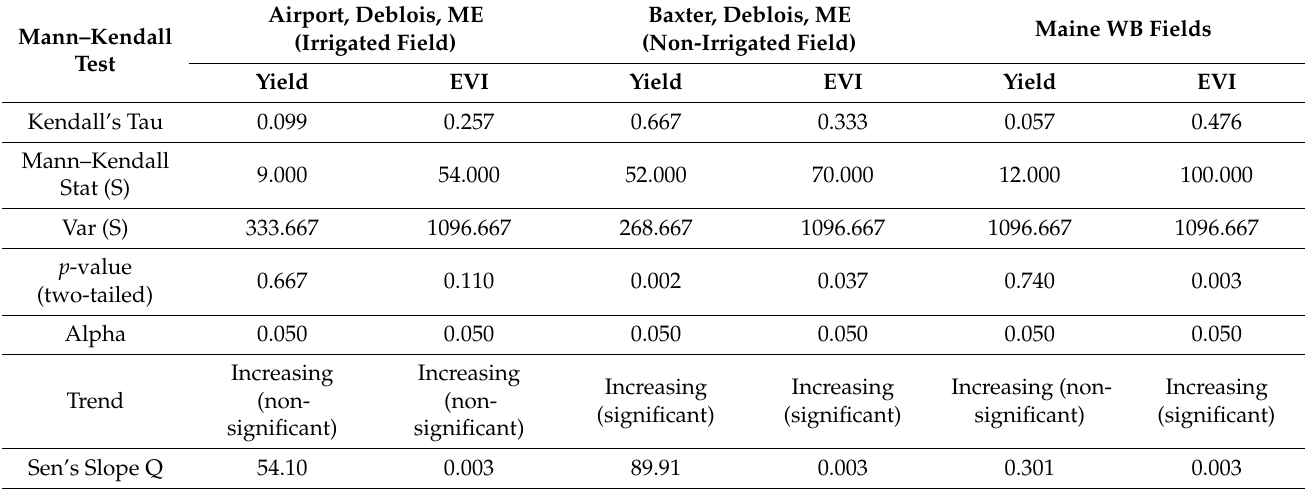
Table 2. Sequential Mann–Kendall trend analysis of yield and enhanced vegetation index (EVI) at three different wild blueberry study zones: Airport (irrigated field, Deblois, ME), Baxter (non-irrigated field, Deblois, ME), and Maine wild blueberry fields (Washington County and Hancock County,